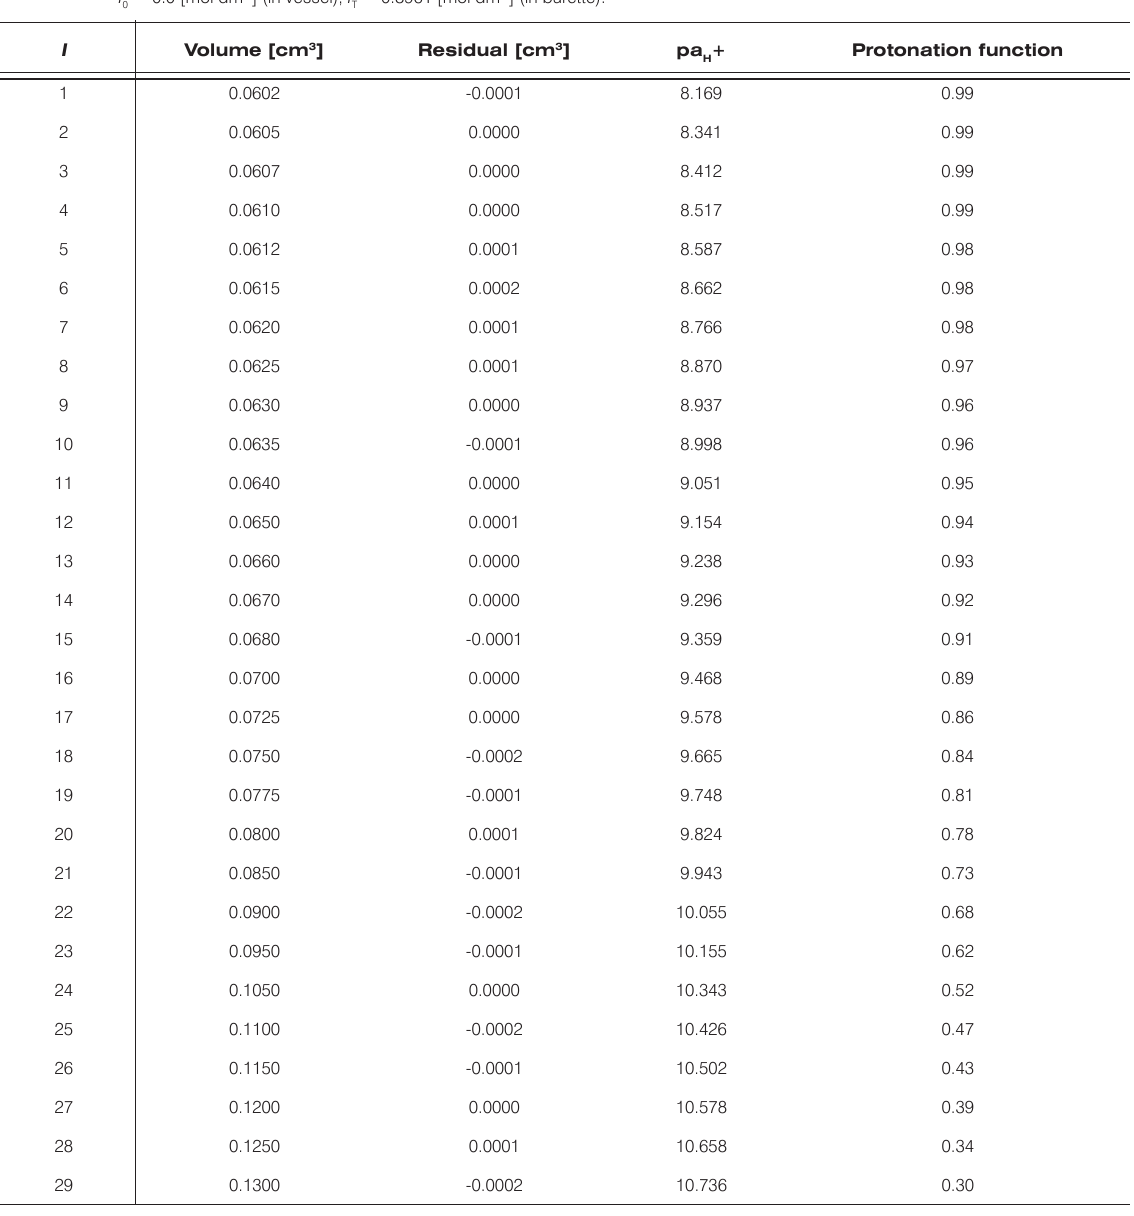
Table 1a. ESAB refinement of common and group parameters for a titration of naphazoline acid with KOH. Common parameters refined: p K